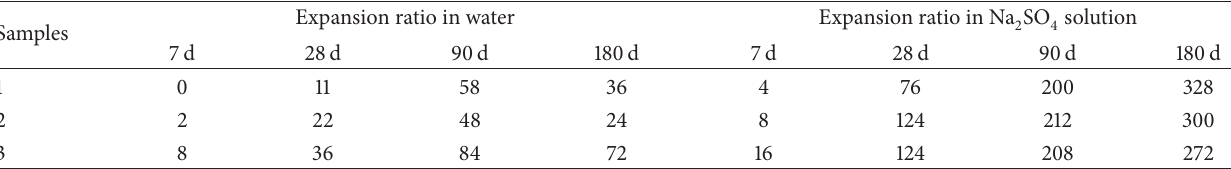
Table 4: Expansion ratio of paste samples.